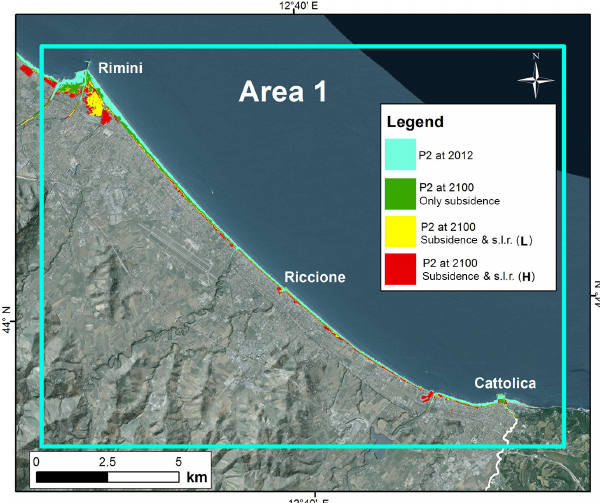
Figure 6. Floodable regions across Area 1 in the case of a storm surge for case P2 in 2100. The assumptions in modelling are colour coded in the inset. In Figs. 6–10 “best” and “worst” refer to the L and H scenarios described in the body of the paper, respectively. Sea-level rise is represented by s.l.r.